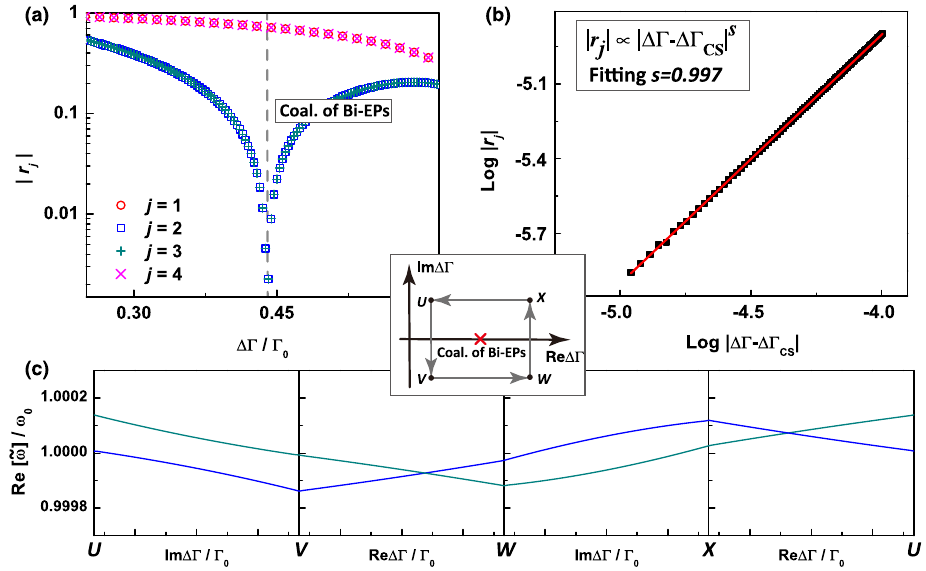
FIG. 6. (a) Phase rigidity of all the eigenstates as functions of asymmetric loss ΔΓ = Γ 0 for the point P 2 in the phase diagram shown in Fig. 2(b). (b) Log-log plot of phase rigidity j r j j versus j ΔΓ − ΔΓ for the coalescence point of two CS- 1 − singularities (filled squares). CS j The fitting result is shown by the solid line, from which the exponent “ s ” of the power law is obtained. The inset shows the looping path in the complex- ΔΓ plane, in which the singularity locates inside the loop. (c) Eigenfrequency trajectories for looping around the coalescence point of two CS- 1 − singularities in the counterclockwise direction ( U → V → W → X → U ) as shown in the